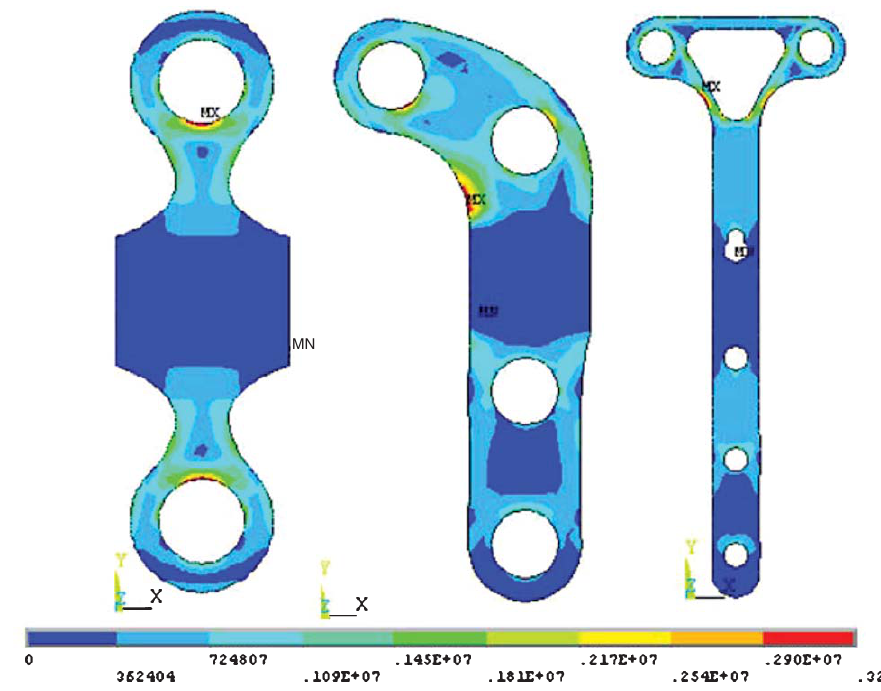
Fig. 11. Von Mises Stress Distribution on the Plates after Topology Optimization (Deformation Scale=1 ∗